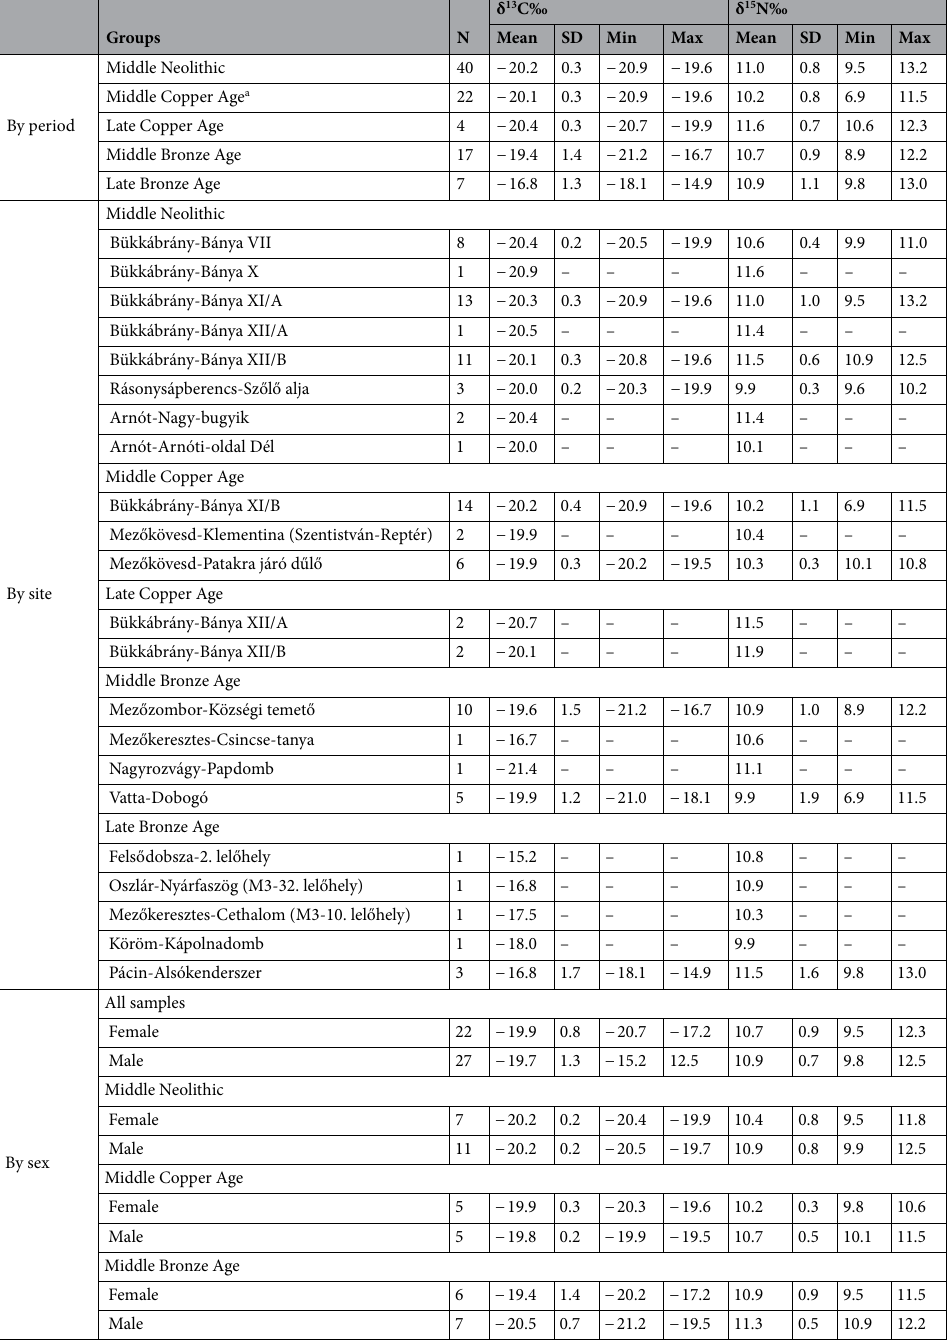
Table 6. Summary of isotopic results of human individuals included in this study. Middle and Bronze Age individuals were previously published in 22 . N total number of individuals (including both adults and young individuals), SD standard deviation (σ), Min minimum values, Max maximum value. a HUNG896 was not